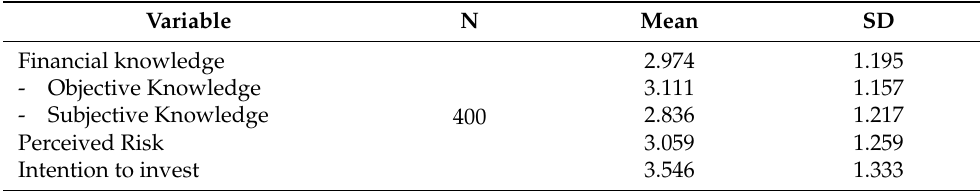
Table 2. The descriptive statistics of the research